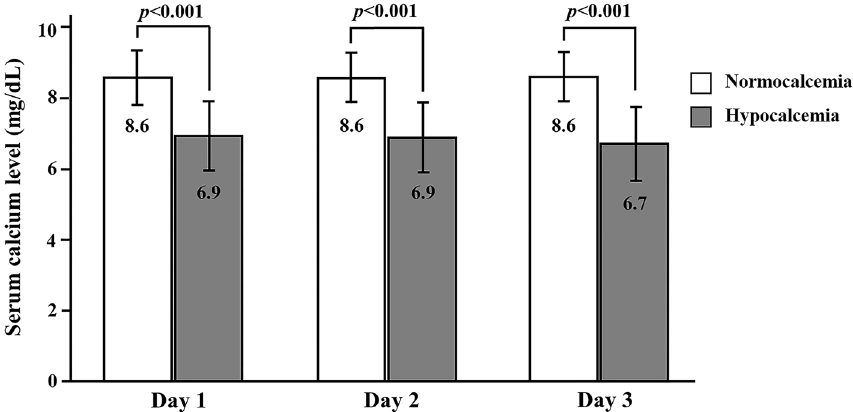
Figure 1. Serum calcium level during the first 3-day postparathyroidectmy period. The bar graph showed a comparison of serum calcium level between patients who developed hypocalcemia after parathyroidectomy and patients who remained normocalcemia during the first 3 days after parathyroidectomy (mean ± SD). The levels of serum calcium at the first (7.0 ± 1.0 mg/dL vs. 8.6 ± 0.8 mg/dL, p < 0.001), second (6.9 ± 0.9 mg/dL vs. 8.6 ± 0.7 mg/dL, p < 0.001) and third day (6.7 ± 1.0 mg/dL vs. 8.6 ± 0.7 mg/dL, p < 0.001) after parathyroidectomy were significantly lower in patients who developed hypocalcemia than those patients who remained